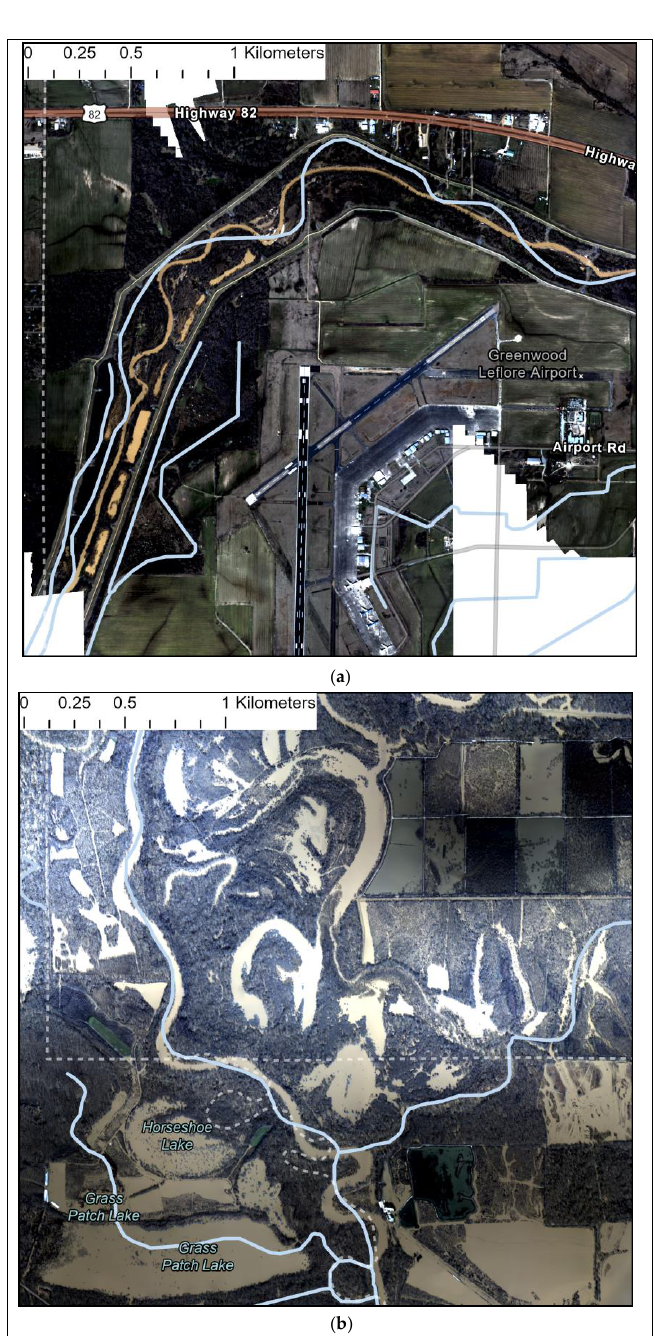
Figure 8. UAS-collected RGB imagery showing flood conditions from ( a ) Feb. 24, 2019 flight near Greenwood-Leflore Airport and ( b ) Feb. 25, 2019 over an agricultural area south of Greenwood, MS. Blue lines denote water flowlines defined by the National Hydrography Dataset.